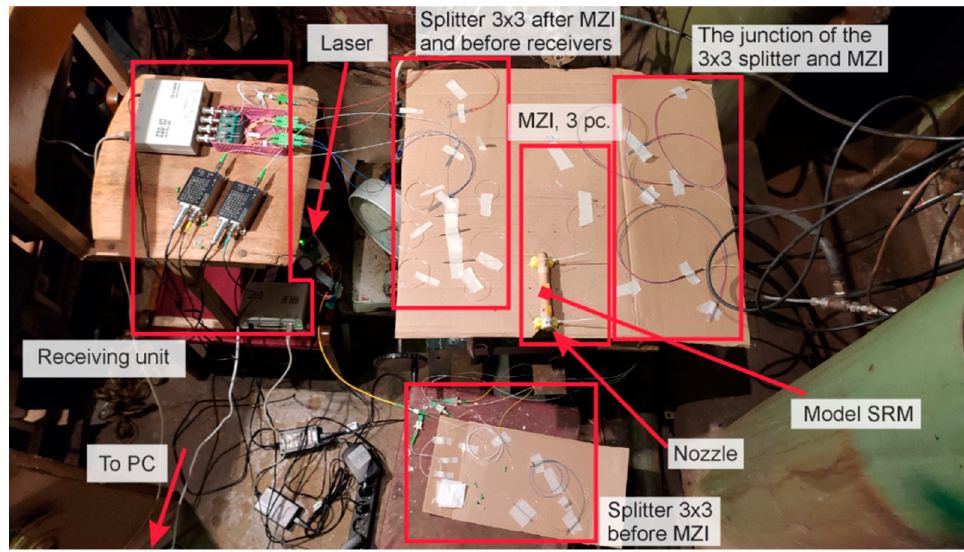
Figure 5. Photo of the assembled laboratory setup.